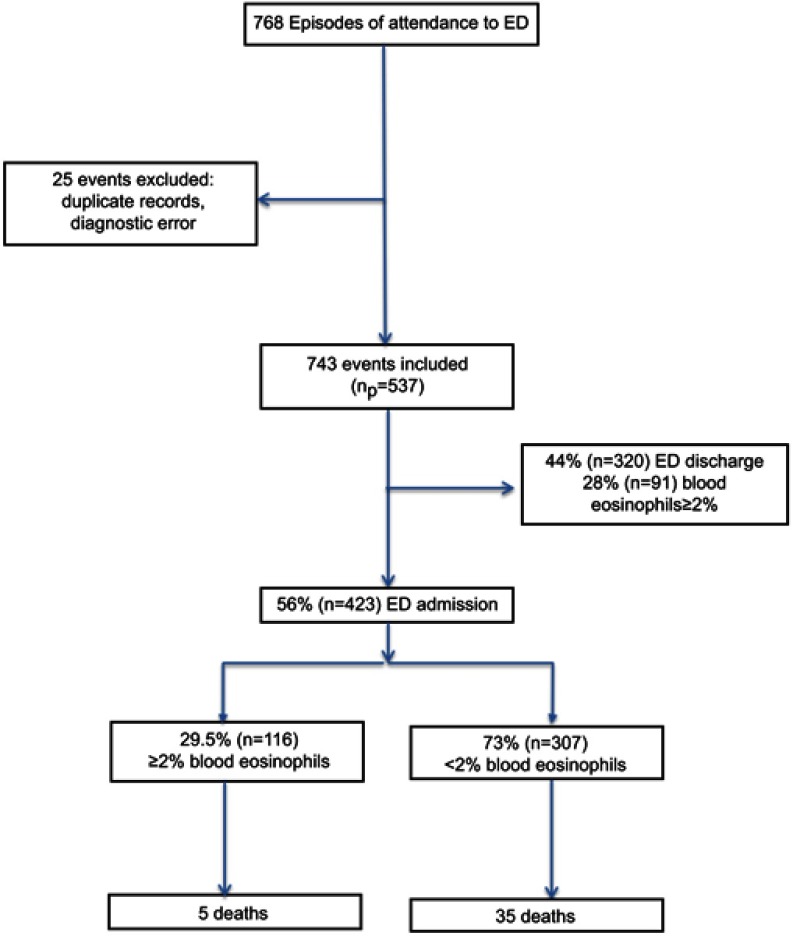
Study consort diagram.Abbreviation: ED, emergency department.